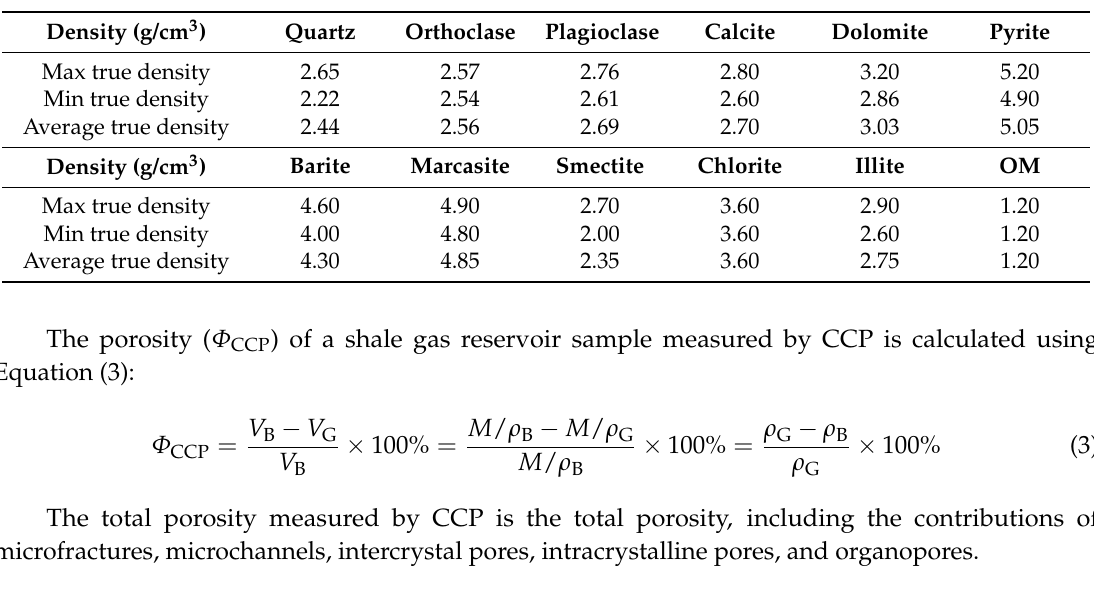
Table 1. The true density values of various minerals and organic matter